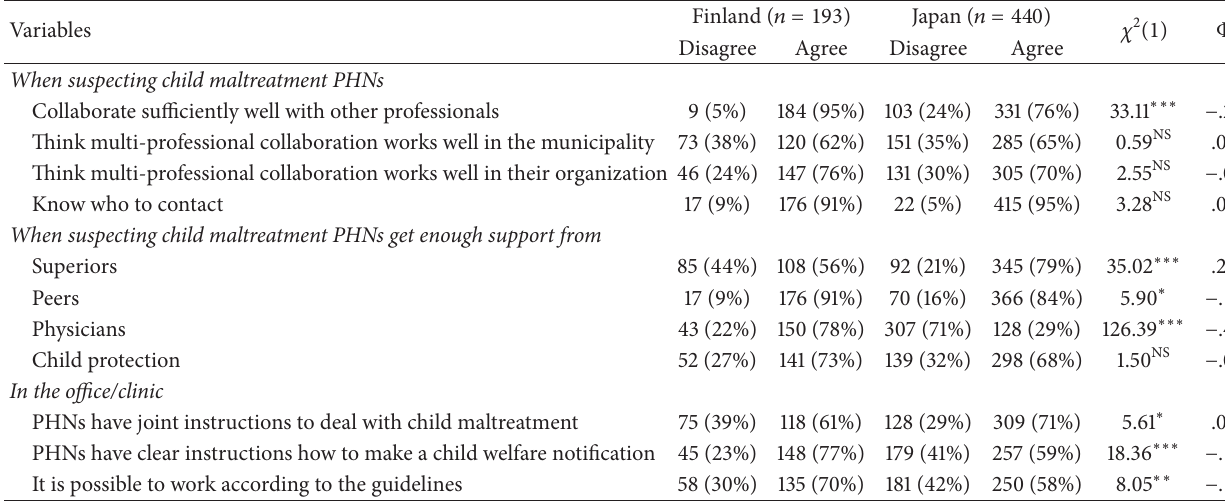
Table 5: Intervention, collaboration, and support from other professionals.